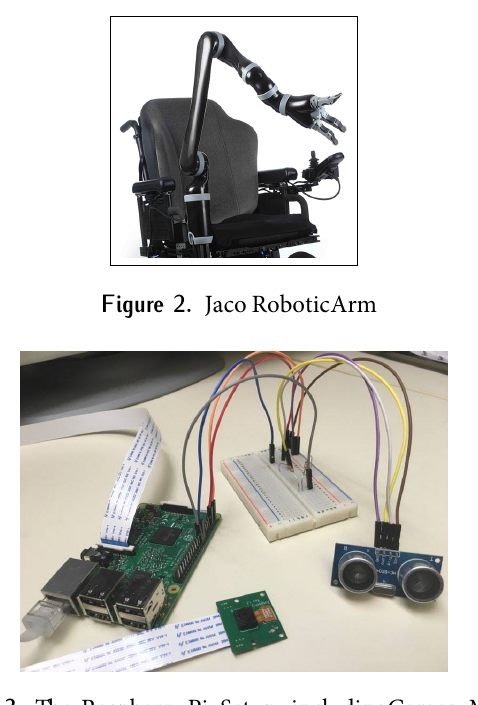
Figure 3. The Raspberry Pi Setup, includingCamera Module and HCSR-04 sensor